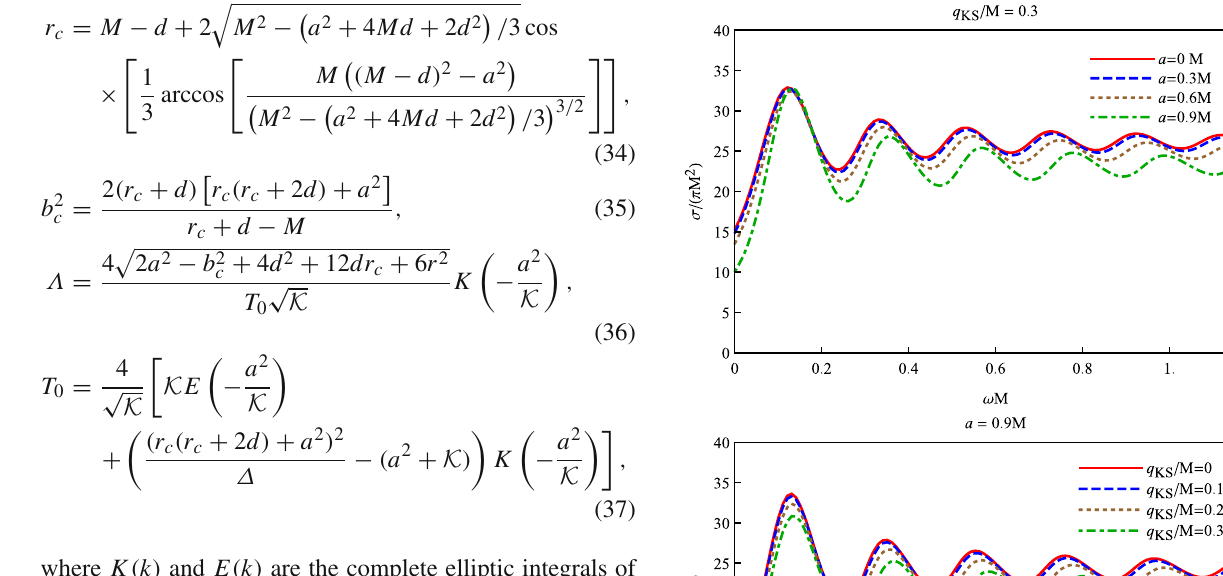
to a smaller absorption cross section, the plots in the bottom panel preserves its essential shape, what does not occur in the top